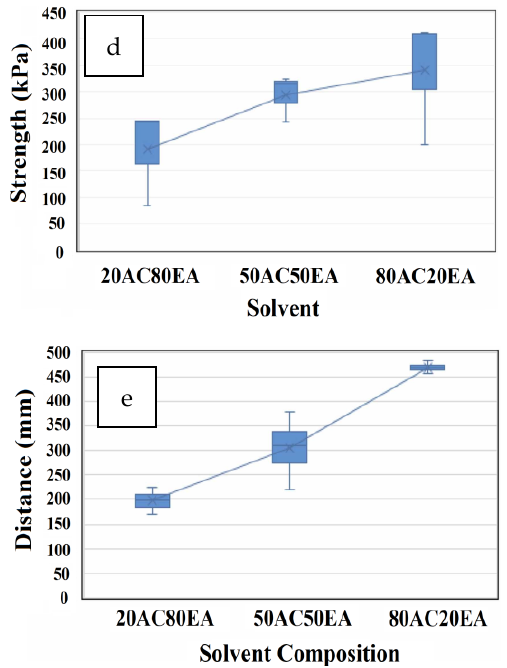
Figure 15. Drying and dissolution of waste EPS. ( a ) dissolution of EPS in acetone/ethyl acetate mixtures; ( b ) bubble formation after drying the waste, ( c ) binder load strength, ( d ) apparent strength shear; and ( e ) stickiness. Reprinted with permission from ref. [49].